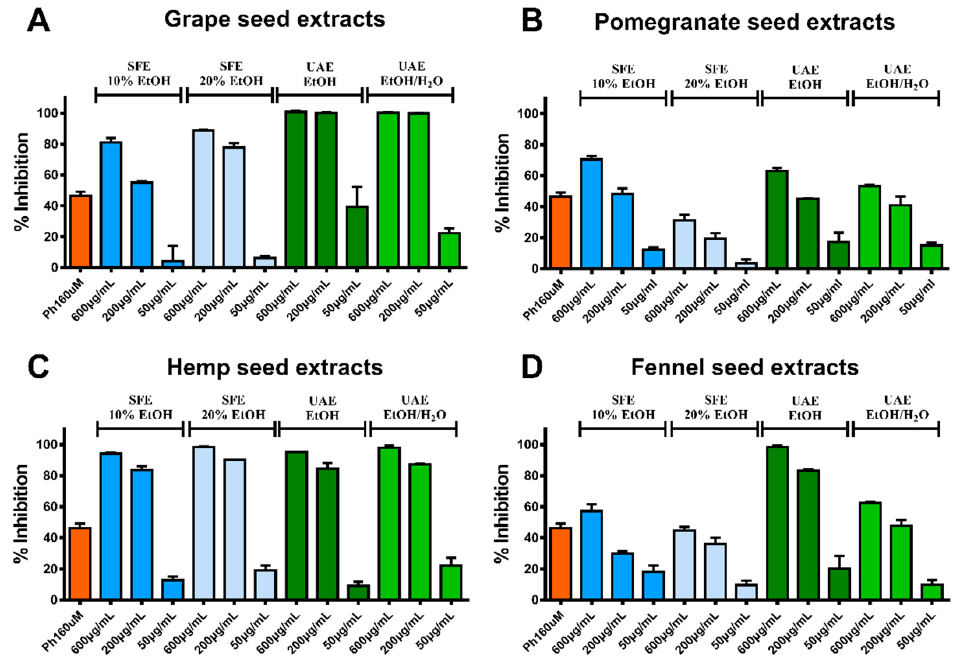
Figure 3. Results of the collagenase activity assay. The percentage of collagenase enzyme inhibition (%) is presented for the produced extracts from ( A ) grape seeds, ( B ) pomegranate seeds, ( C ) hemp seed and ( D ) fennel seeds. Phosphoramidon (PRMD) was used as positive control.